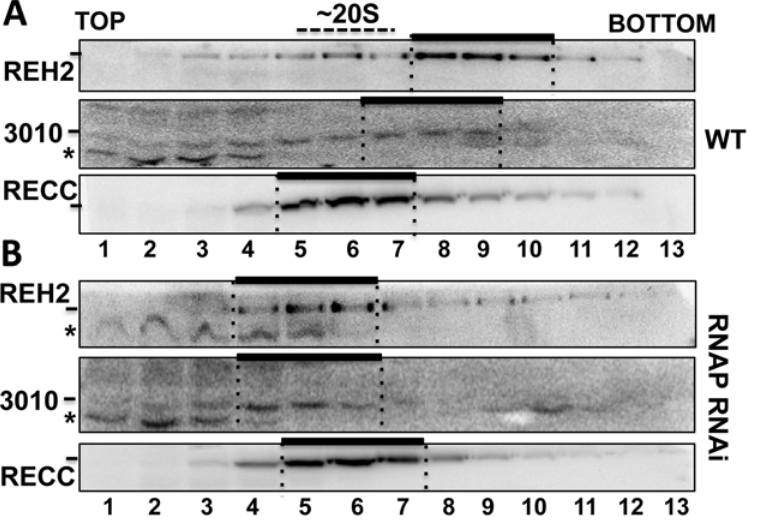
Fig 7. Sedimentation of MRBs. REH2 and 3010 MRBs in 10 – 30% glycerol gradients of mitochondrial extract from (A) wild-type (WT) or (B) RNAP knockdown cells at day 3 post-induction. The RECC complex (MB63 subunit) is at ~20S in panels A and B. Some proteolysis ( * ) occurs in the top fractions. Bars mark major peaks of REH2, 3010, and RECC examined in western